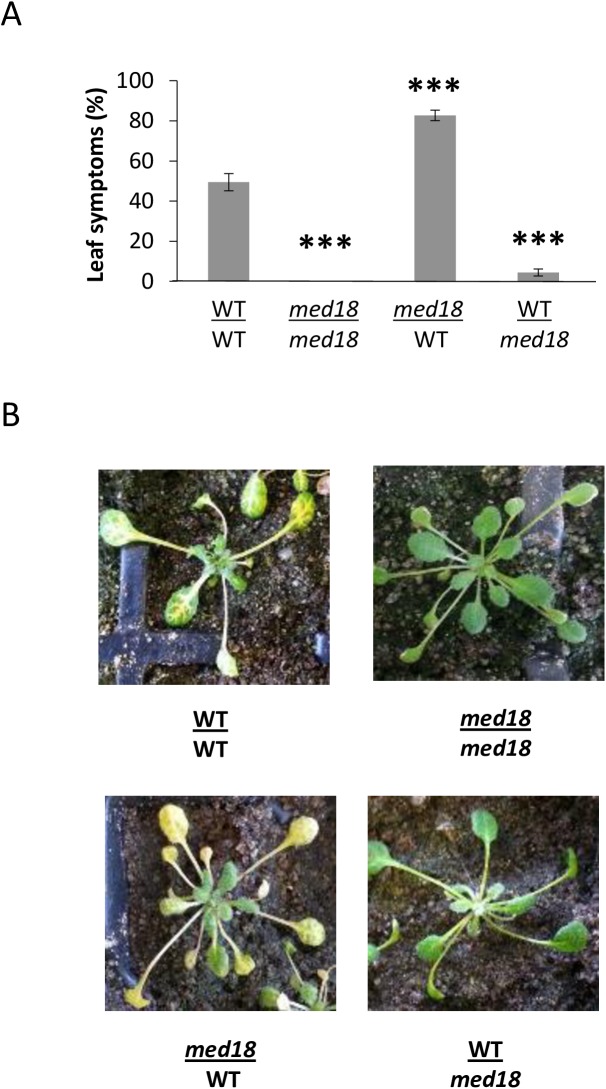
The resistance of med18 is mediated by the roots.Reciprocal grafts made between the WT (Col-0) and med18 seedlings revealed that roots containing the med18 root genotype were highly resistant to infection, whereas med18/WT or WT/WT self-grafts were highly susceptible. (A) shows the average percentage of leaf chlorosis from eighteen plants per graft combination. Error bars represent standard error. (B) shows typical disease symptoms at 12 days after infection. *** represents significance (p<0.001) using Student’s T-test of each mutant compared to the WT/WT self-graft.